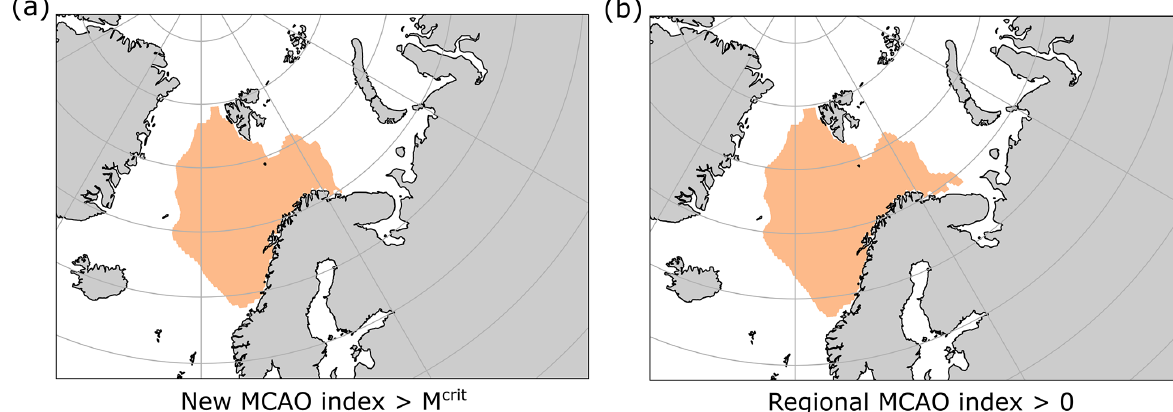
Figure D1. Comparison of dichotomized regional and new MCAO index for one exemplary time step (at 14:00UTC on 24 March 2011). (a) New MCAO index ( m p , Eq. 3). Orange area: the new MCAO index is larger than the critical threshold determined via the analyses in Sect. 3.3.3 (i.e. m p > M crit p = 330hPa). (b) Regional index ( m θ (p crit ) , Eq. 7). Orange area: the regional index is larger than zero. As described in Sect. 3.3.4, the critical pressure level for computation of the regional index can be obtained as p crit = p 0 − M crit p = 1013 . 25 − 330 = 683 . 25hPa. The comparison provides a numerical example to illustrate that m p > M crit p implies m θ (p crit ) > 0 (assuming that potential temperature increases with height in the top layers of MCAOs). This means that the skill of the new MCAO index in distinguishing times and locations of PLs with a critical threshold of 330hPa also holds for the regional MCAO index with a critical threshold of 0, because the classification is based on the dichotomized index values (Eq. 6, Sect. 3.3.3). Note that for the example illustrated here we compute the regional index based on ERA5 data on the nearest pressure level (700hPa ≈ 683 . 25hPa) to show that this may be used as a computationally cheaper approximation. The new MCAO index is calculated based on ERA5 data on model levels with interpolation to the pressure level where θ(p ∗ ) = θ skin . This explains the small deviations between the two orange